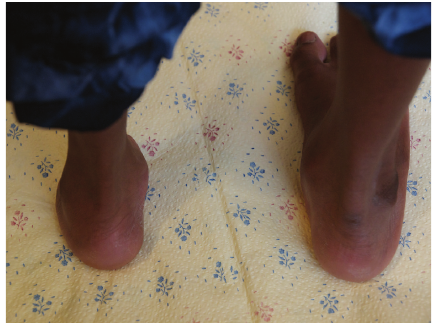
Figure 2: View from posterior of transverse